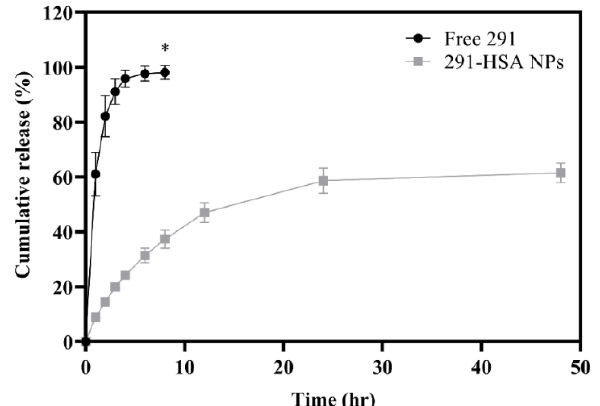
Figure 7. In vitro drug-release profiles of free MPT0B291 and MPT0B291-human serum albumin (HSA) nanoparticles (NPs) in pH 7.4 phosphate buffer containing 1% Tween 80 at 37 °C. Data